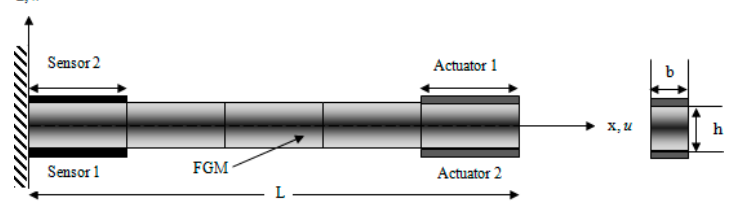
Figure 1. Geometry of an embedded-free Functional Graded Materials (FGM) beam containing piezoelectric layers.